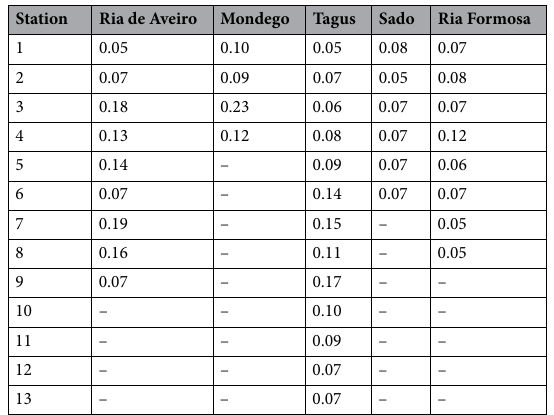
Table 5. RMSE (m) for the estuarine systems under study. The numbers represent the stations shown in Fig. S1 of the supplementary